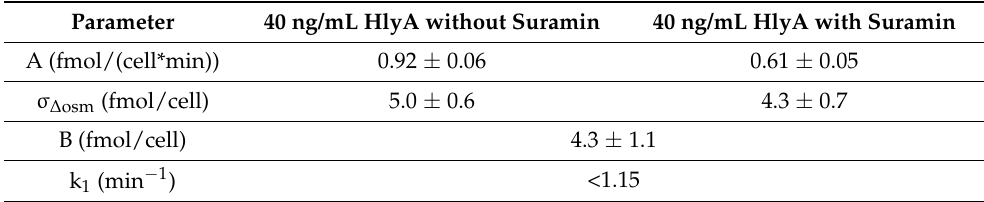
Table A1. Parameters obtained from model 2 fitting to data in Figure 8A,C. The best fit value of k 1 was 0.5 min − 1 . However, the indetermination of the parameter (0.65 min − 1 ) does not allow k 1 to be expressed as the value ± standard error. Model fitting indicates that the value of k 1 should be between 0 and 1.15 min − 1